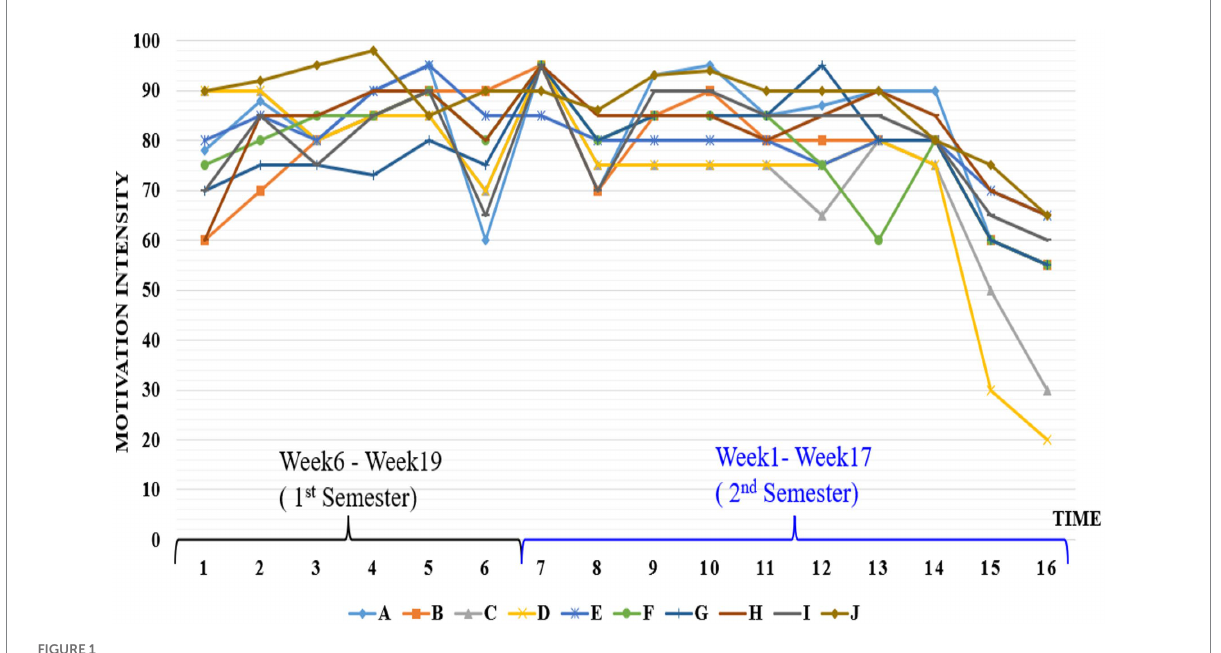
FIGURE 1 Trajectories of 10 participants’ motivation